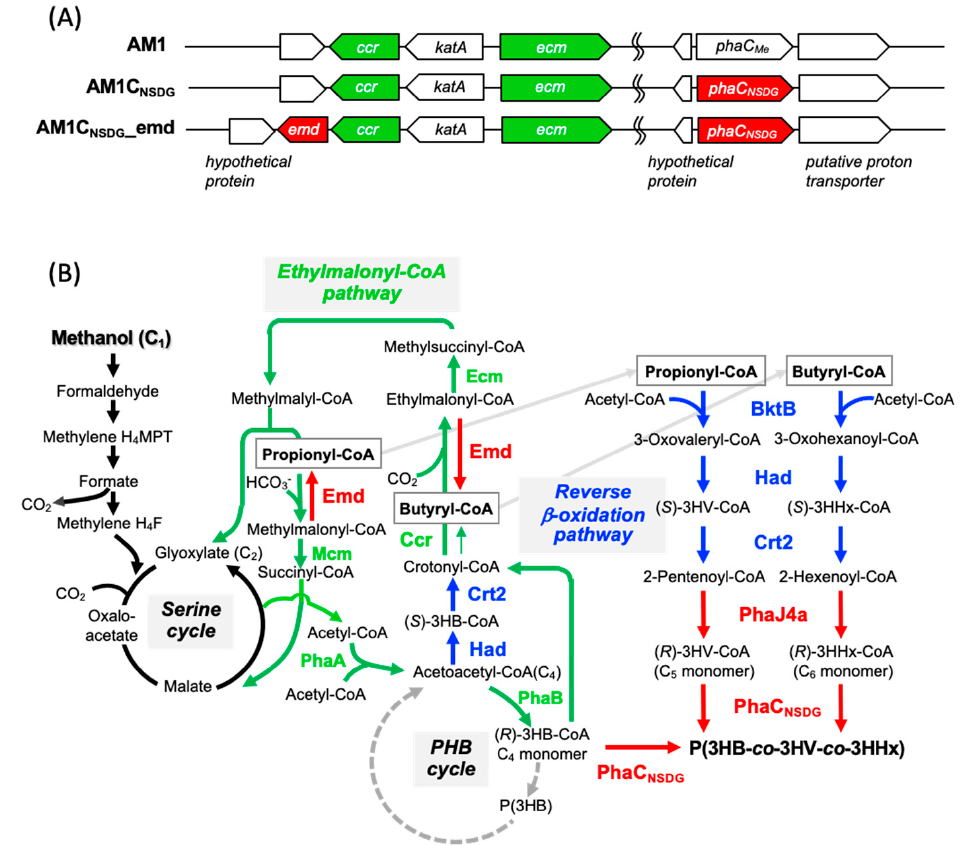
Figure 1. ( A ) Organization of modified genes on chromosome of M. extorquens AM1 for PHA biosynthesis. ( B ) Methanol assimilation and P(3HB- co -3HV- co -3HHx) biosynthesis pathways in M. extorquens AM1C NSDG _emd harboring genes for RBO pathway. 2PG, 2-phosphoglycerate; PEP, phos-